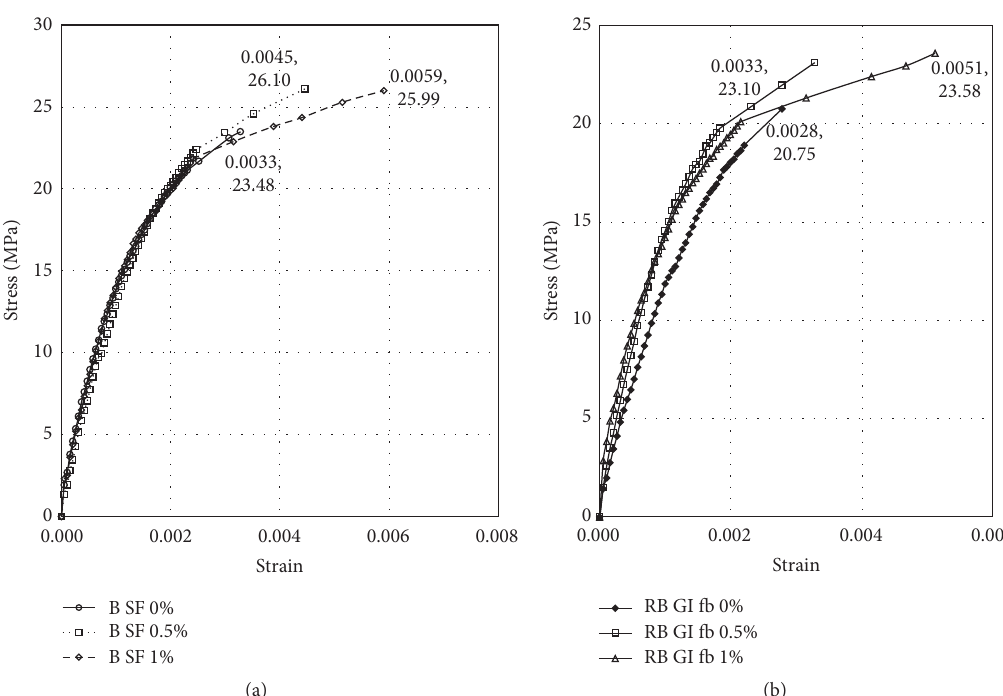
Figure 13: Stress-Strain diagram at 28 day; (a) B aggregate and (b) RB